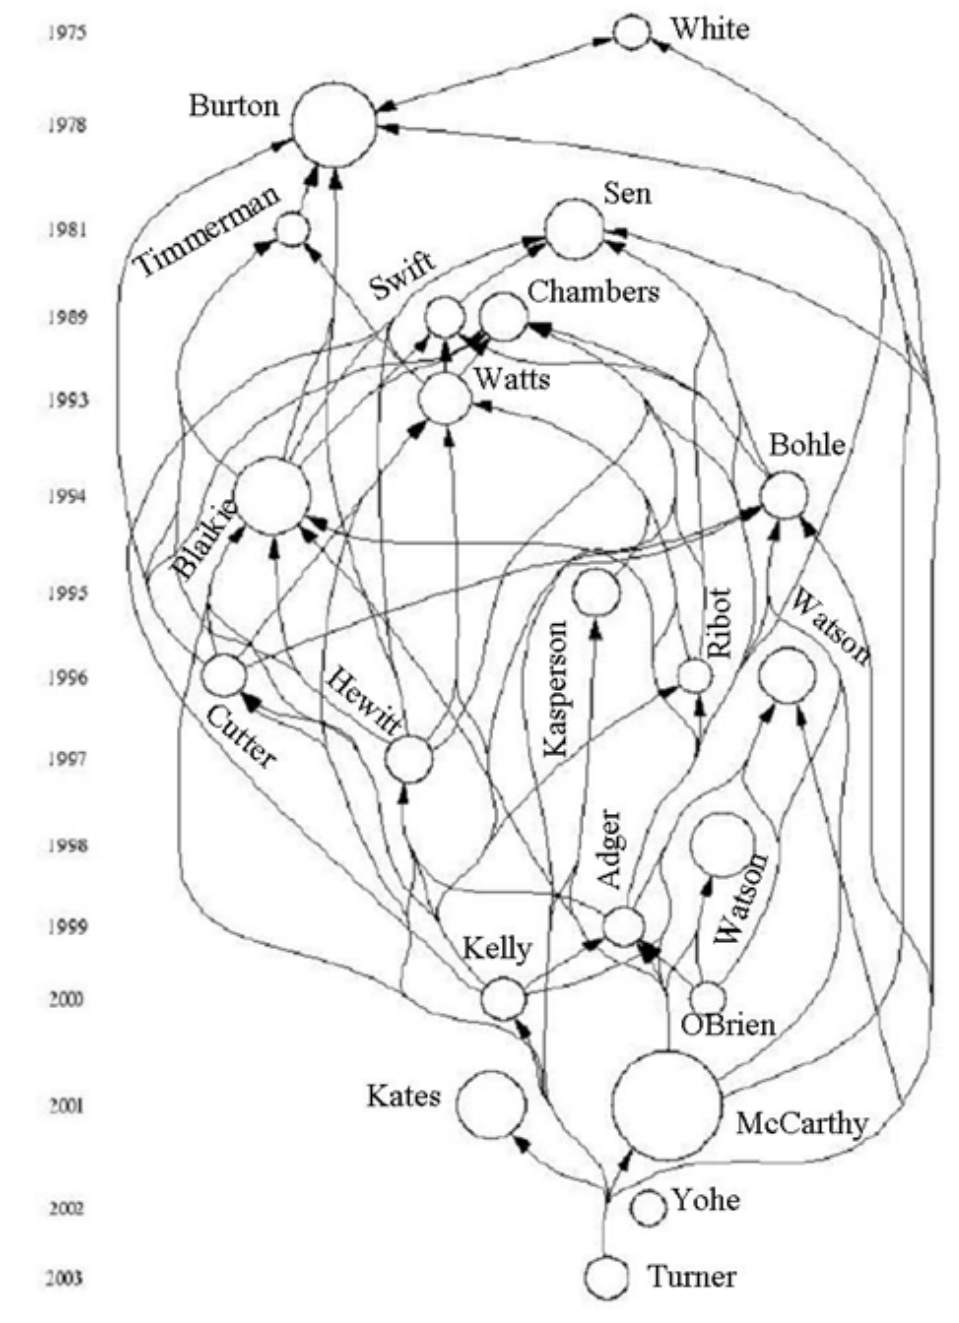
Fig. 5. Paper citation network of the most highly cited papers within the vulnerability knowledge domain (Threshold 30 citations within the data set). The node size denotes the number of citations, the arrows refer to